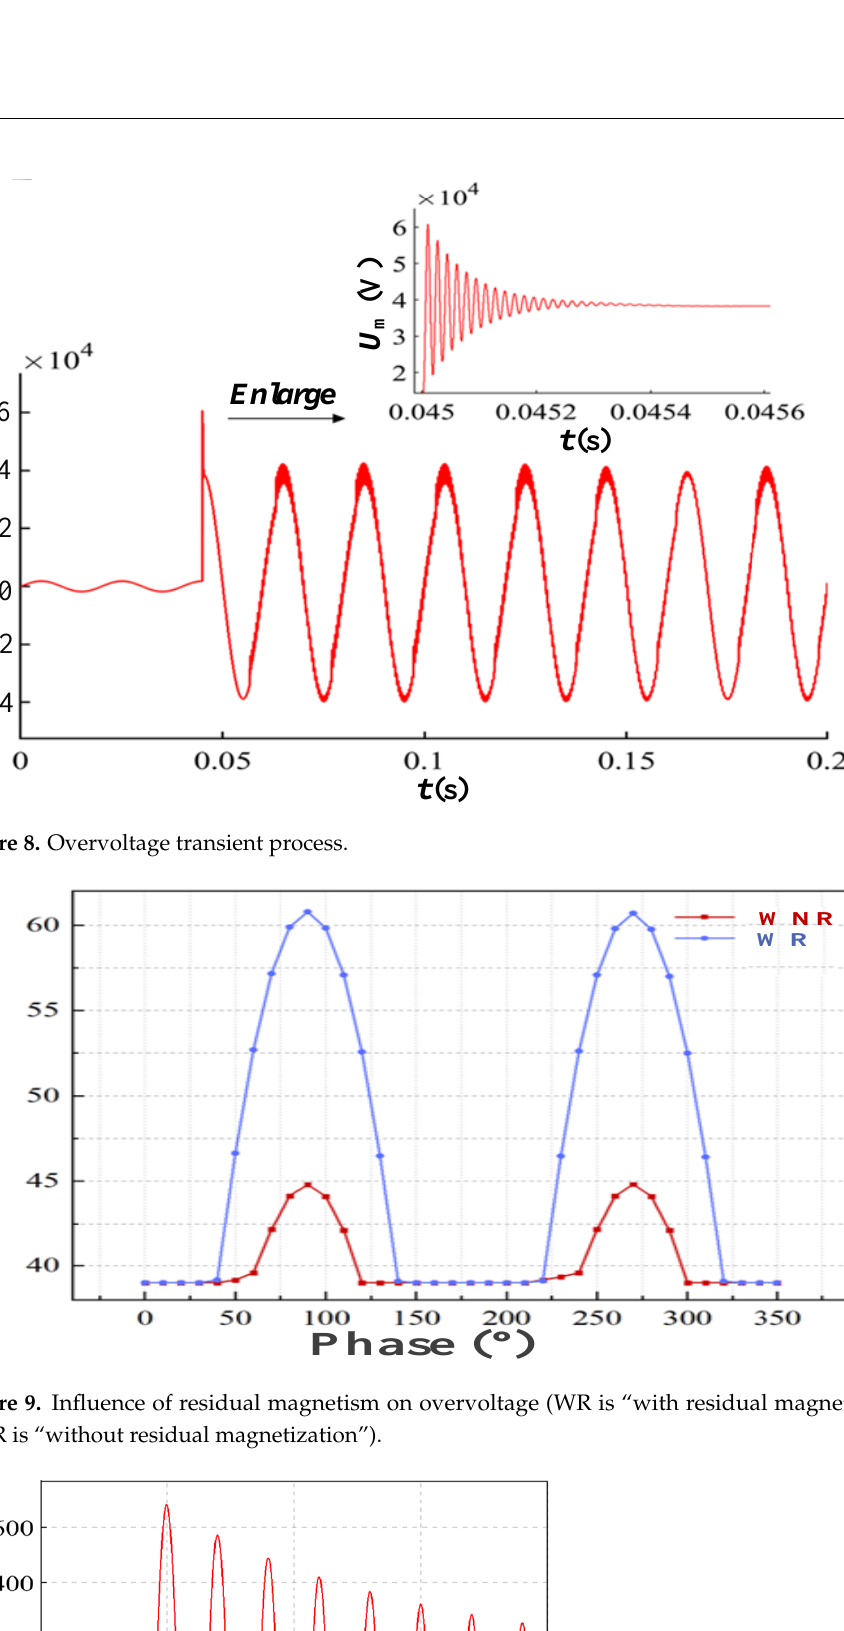
Figure 10. Magnetizing inrush current waveforms on the primary side of vehicle-mounted trans- former closing at 0°.